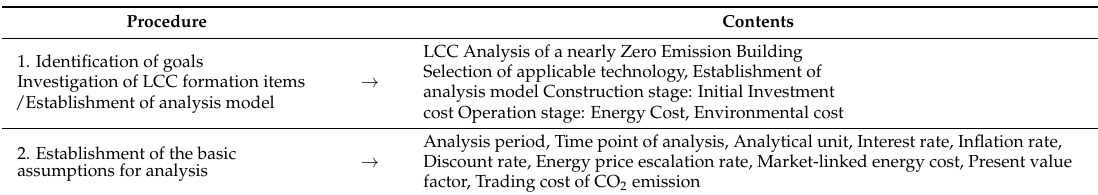
Table 1. LCC Analysis procedure of